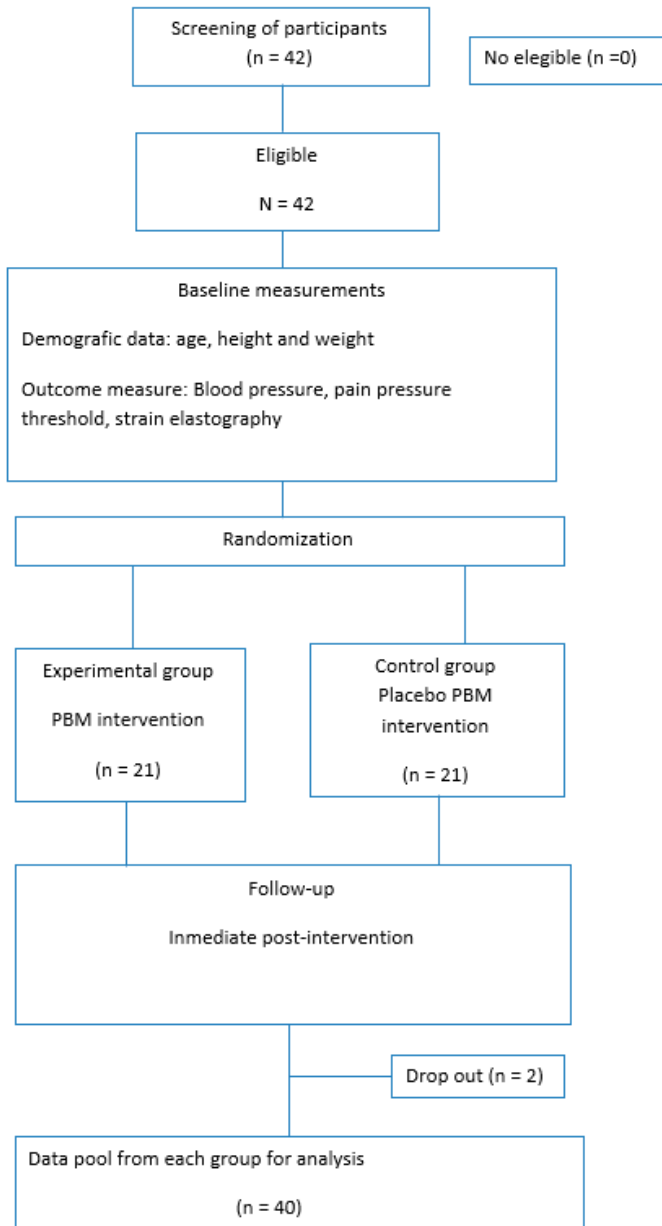
Figure 3. Assessment